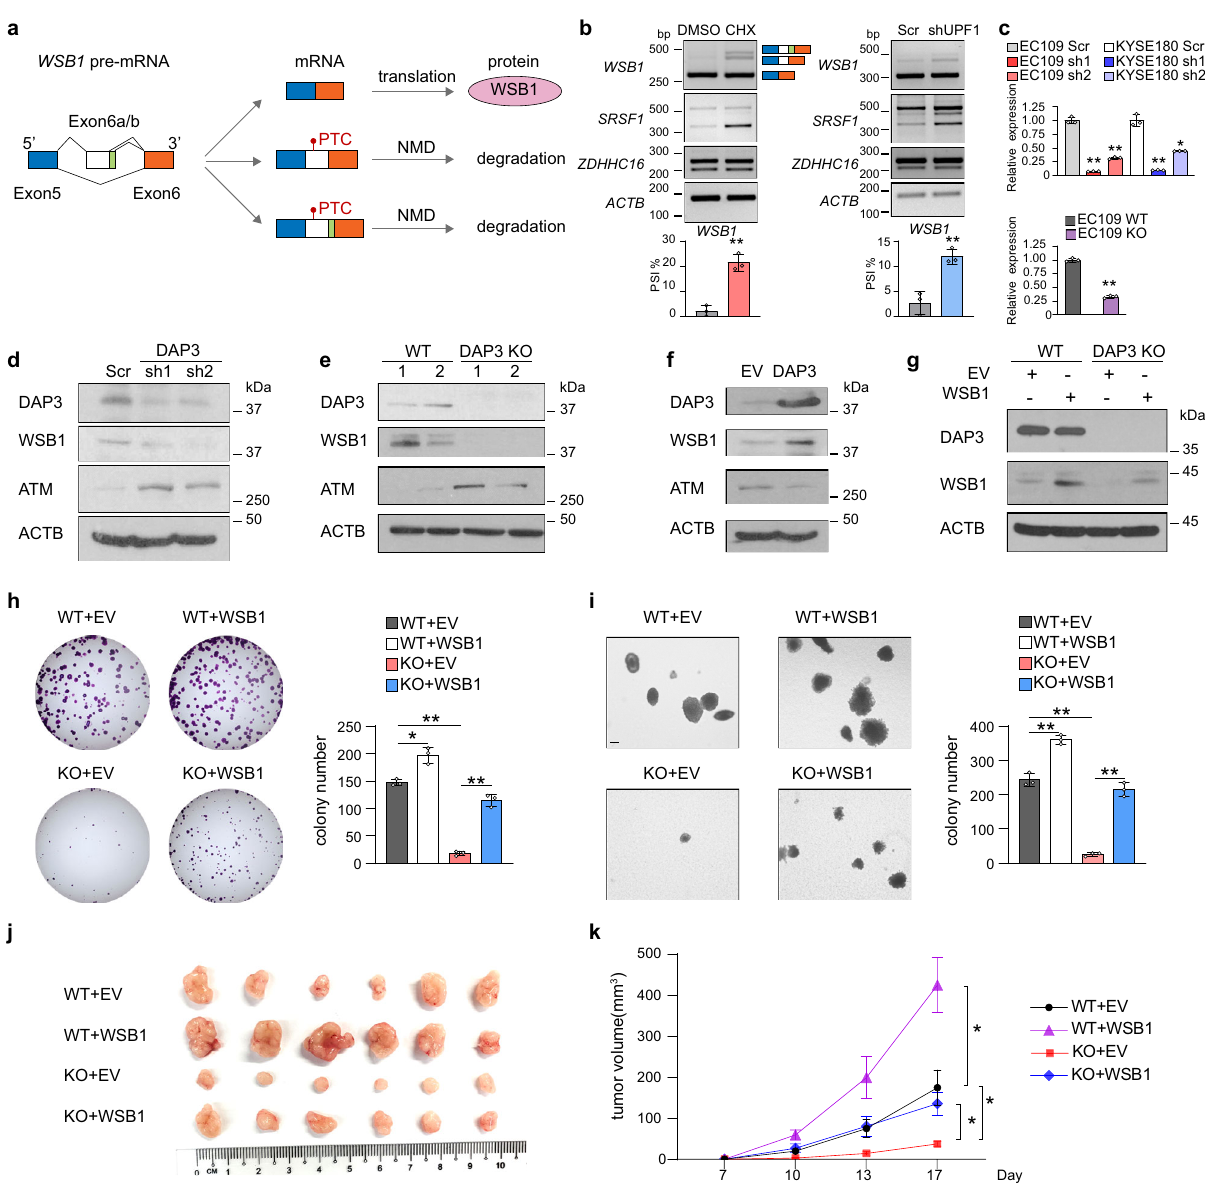
Fig. 7 DAP3 increases WSB1 expression via suppressing AS-NMD of WSB1 to promote tumorigenesis. a Schematic diagram illustrating the inclusion of non-canonical exon E6a and E6b introduces a PTC to WSB1 mRNA transcript, which may result in NMD. b Semiquantitative RT-PCR analysis of the WSB1 splicing upon inhibition of NMD. Left panel: EC109 cells were treated with CHX or vehicle control (DMSO) for 6 h. Right panel: EC109 cells were transfected with shUPF1 or the scramble control (Scr) for 48 h. SRSF1 or ZDHHC16 serves as a positive or negative control, respectively, to ensure successful inhibition of NMD. ACTB was used as a housekeeping gene internal control. Data are represented as mean ± s.d. of n = 3 biologically independent samples. c qRT-PCR analysis of the change in expression of WSB1 canonical isoform (E6a/6b-skipped) upon DAP3 -KD (upper panel) or KO (lower panel). ACTB was used as a housekeeping gene internal control. Data are represented as mean ± s.d. of technical triplicates. d – f Western blot analyses of DAP3, WSB1, ATM, and ACTB protein expression in d DAP3 -KD EC109 cells, e DAP3 -KO EC109 cells ( “ 1 ” and “ 2 ” indicate two different WT or KO clones), and f EC109 cells with DAP3 overexpression. EV empty vector control. g Western blot analysis of DAP3 and WSB1 protein expression in DAP3 - KO or WT EC109 cells that were overexpressed with the empty vector control or WSB1 construct. h, i Quanti fi cation of foci formation ( h ) or soft agar colony formation ( i ) induced by the indicated stable cells. Scale bar: 200 μ m. Data are represented as mean ± s.d. of n = 3 biologically independent wells. b , c , h , i Statistical signi fi cance is determined by unpaired, two-tailed Student ’ s t -test (* p < 0.05, ** p < 0.01). j Xenograft tumors derived from the indicated stable cell lines at end point ( n = 6 mice per group). k Growth curve of tumors derived from the indicated cells in mice, over a 17-day observation period. Data are presented as the mean ± s.e.m. Statistical signi fi cance is determined by unpaired, two-tailed Student ’ s t -test (* p < 0.05). Exact p -values and source data are provided in Source Data fi